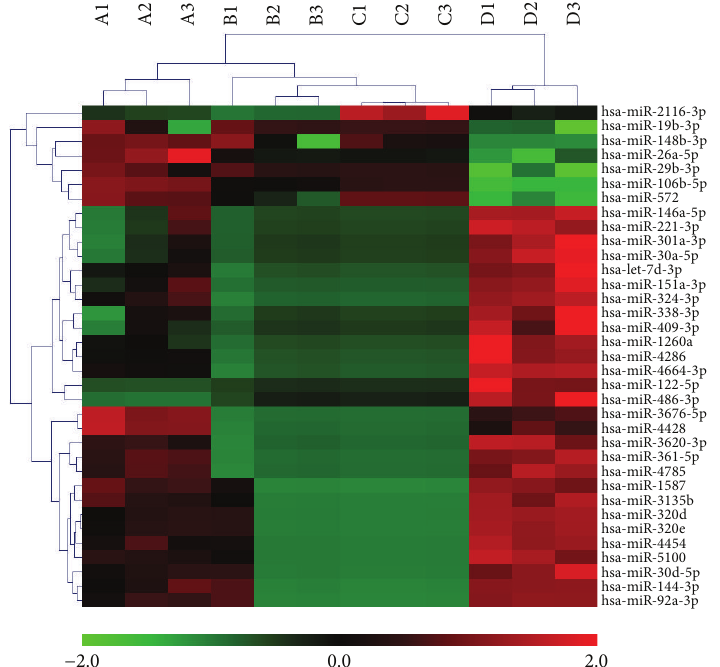
Figure 1: Clustering and principle component analysis of 35 miRNAs with significantly different expression values ( 𝑝 value < 0.05; FC ≥ 2 ). Unsupervised hierarchical clustering analysis of 35 miRNAs with significantly different expression values in T2DM with D-IBS (A), T2DM (B), and D-IBS (C) compared with the matched samples (D). One through three represent three different patients for each group. The color key under the heat map represents the different expression levels. Expression levels of miRNAs are shown in red (upregulated) and green (downregulated), with brighter shades indicating higher fold